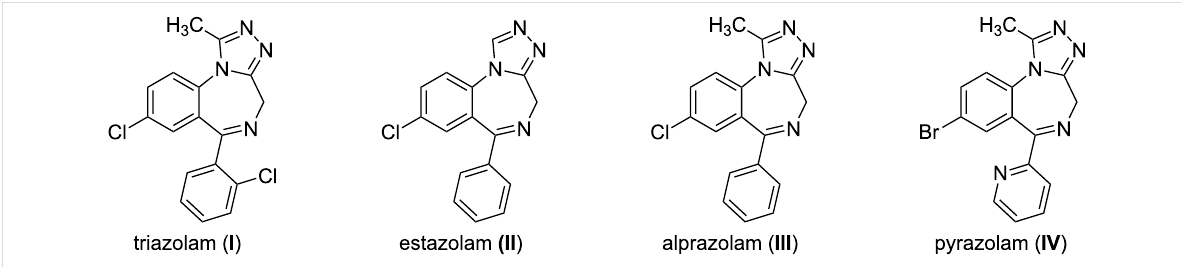
Figure 1: Examples of marketed pharmaceutical 1,2,4-triazolobenzodiazepines.